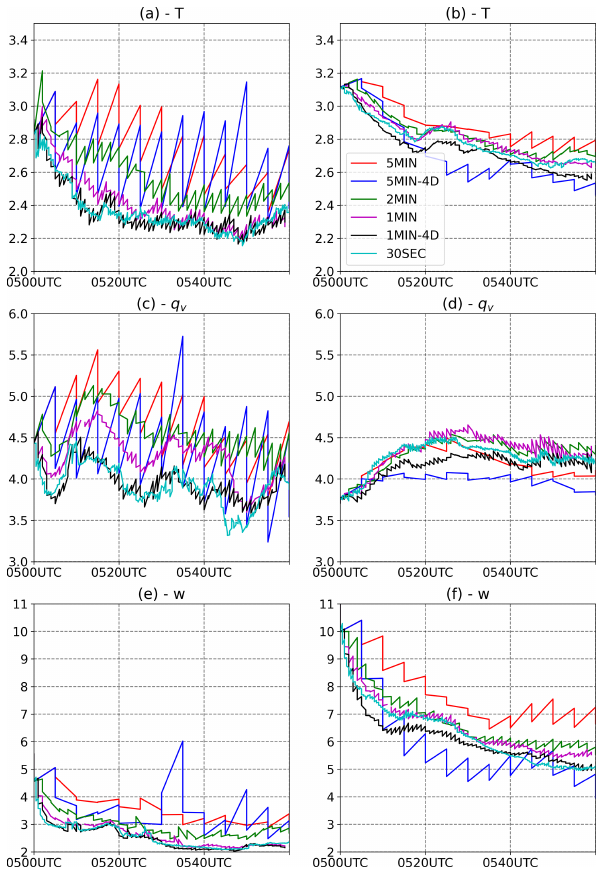
Figure 7. Sawtooth time series of the KLD (10 − 2 ) of the analysis and first guess vertically and horizontally averaged over the precip- itating ( > 30dBZ; a , c , e ) and non-precipitating ( < 0dBZ; b , d , f ) grid points for temperature (a, b) , specific humidity (c, d) , and ver- tical velocity (e, f) and for the 5MIN (red), 5MIN-4D (blue), 2MIN (green), 1MIN (magenta), 1MIN-4D (black), and 30SEC (cyan) ex- periments.